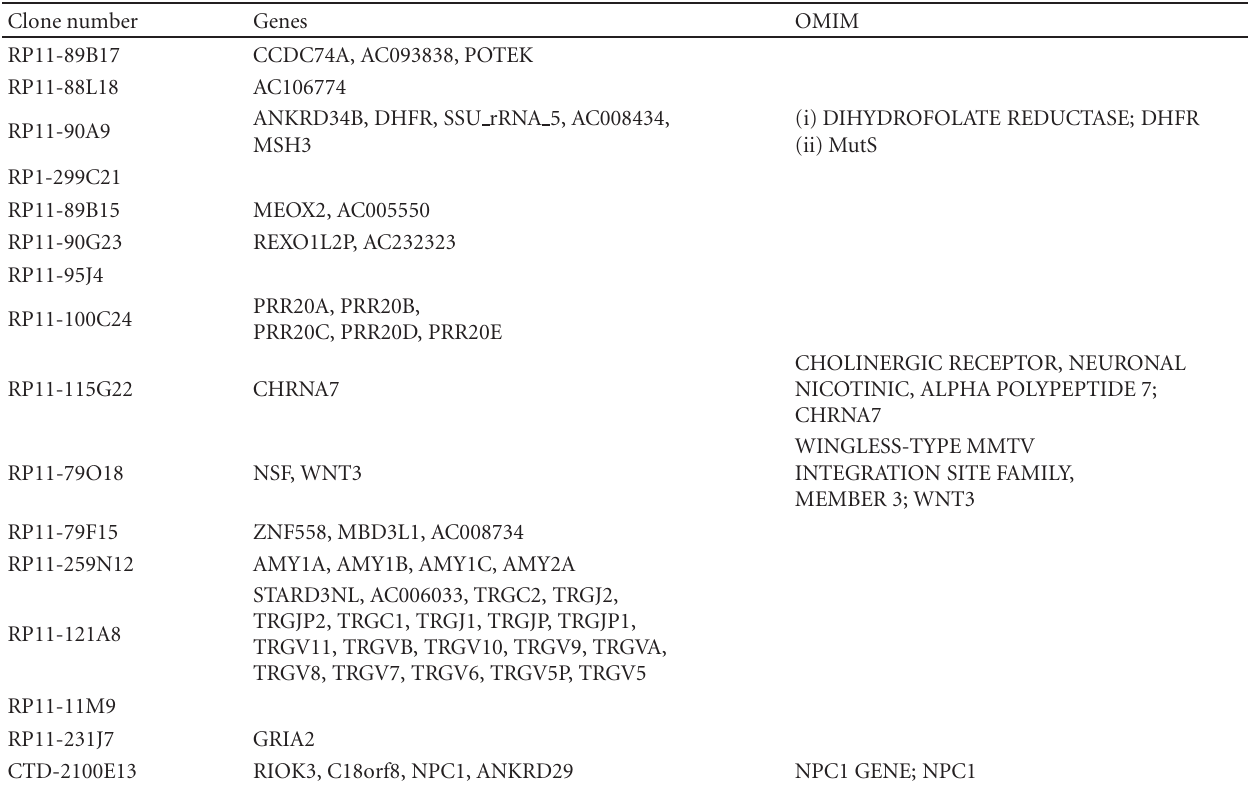
Table 2: Genes or disease gene (OMIM ∗ ) in BAC clones with highly polymorphic